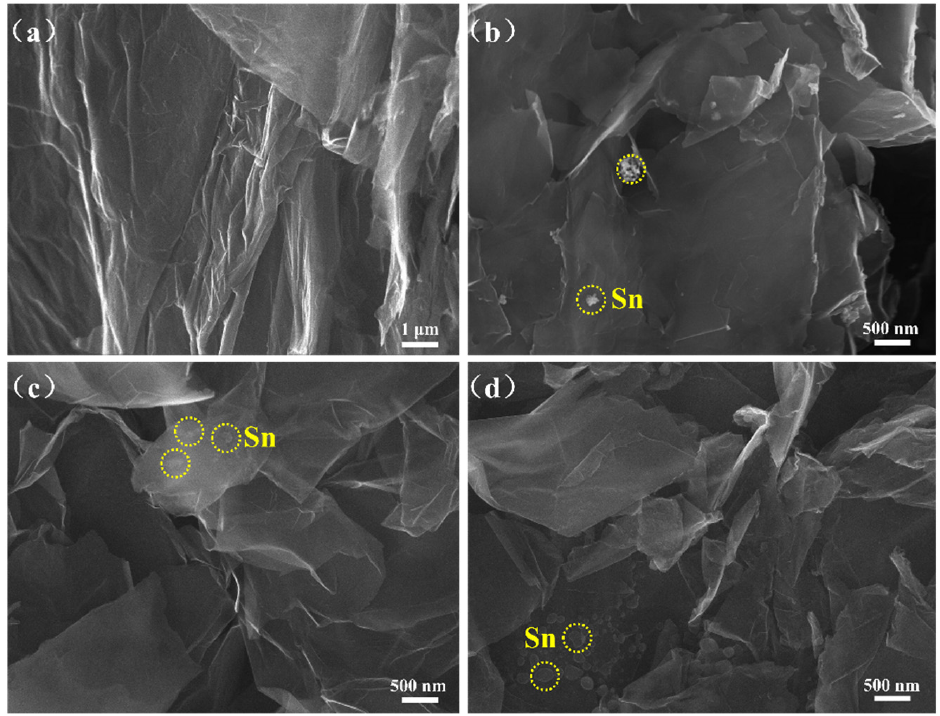
Figure 2. Typical SEM of graphene ( a ), C@Sn/NSGr–5 ( b ), C@Sn/NSGr–7.5 ( c ) and C@Sn/NSGr–10 ( d ). For investigating the composition and bonding state of the surface energy of the C@Sn/NSGr-7.5 sample, X-ray photoemission spectroscopy (XPS) was carried out. a clearly demonstrates the presence of C, Sn, O, N, and S elements in C@Sn/NSGr-7.5, further verifying that the electrochemical exfoliation process could effectively dope the nitrogen and sulfur elements. Figure 4b shows the high-resolution spectrum of C 1s. Peaks appeared at about 284.8 eV, 285.3 eV, 285.6 eV and 286.4 eV, corresponding to the C − C/C=C, C − S, C − N and C − O bonds, respectively [37]. In the high-resolution spectrum of Sn 3d (Figure 4c), The Sn 3d 5/2 peak was split into three peaks with binding energies of 487.6 eV (Sn 4+ ), 487 eV (Sn 2+ ) and 485.2 eV (Sn), and the Sn 3d 3/2 peak was split into three peaks with binding energies of 496.1 eV (Sn 4+ ), 495.2 eV (Sn 2+ ) and 493.8 eV (Sn). These results proved that electroless plating could reduce Sn 2+ to metallic tin. There was a combination of Sn 4+ and Sn 2+ in the tin, which could be caused by the partial oxidation of metal Sn, consistent with the results of the O 1s spectrum [38,39]. Three peaks appear at about 531.8 eV, 534.0 eV and 531.0 eV in Figure 4d, which refer to the bonds of C=O, C − O and Sn − O − C, respectively. Figure 4e shows that three peaks were located at about 401.7 eV, 399.8 eV and 398.5eV, which corresponded to the bonds of graphitic N, pyridinic N and pyrrolic N [40], respectively. In the high resolution of S 2p, Figure 4f demonstrates that there were three peaks at around 163.7 eV, 165.2 eV and 168.8 eV, which were assigned to the chemical bond energies of C − S − C, C − S − C and C − SO x [41,42], respectively. Noteworthily, nitrogen and sulfur co-doping contributed to increase the lithium storage capacity and promote charge transport and ion